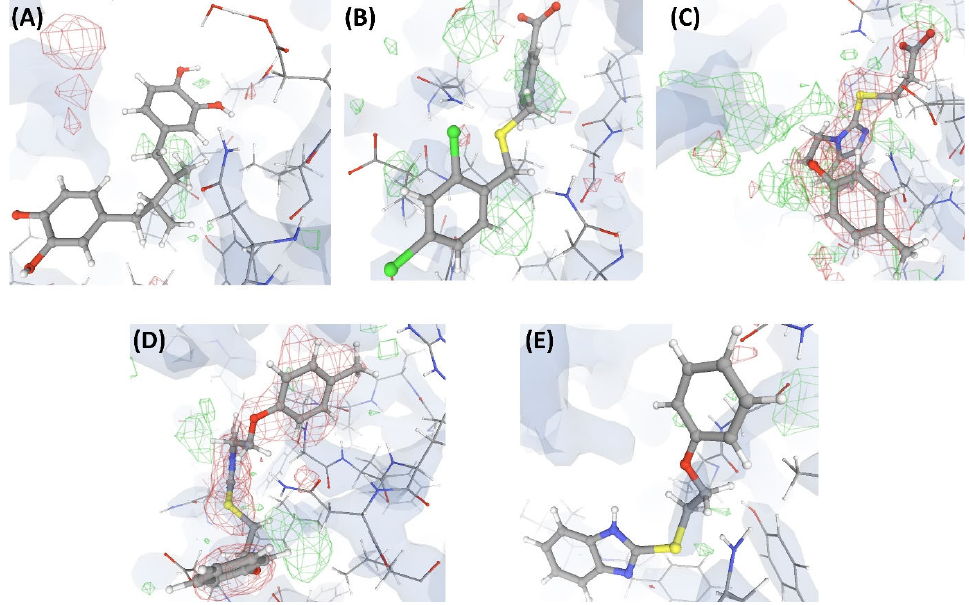
Figure 4. Electron density maps around the ligands bound at site S1 of the structures discussed in case study ‐ 1. ( A ) L1 in C1 (2.3 Å). ( B ) L2 in C2 (2.3 Å). ( C ) L3 in C3 (2.4 Å). ( D ) L4 in C4 (2.5 Å). ( E ) L10 in C17 (2.5 Å). The ligands are shown as a ball and stick model. The neighboring protein residues are shown as thin sticks. The blue translucent blobs are the ‘2 mFo ‐ DFc’ maps contoured at 1.5 σ , surrounding all well ‐ determined atoms in the models. The ‘mFo ‐ DFc’ maps (also called difference; shown as mesh) are colored as red (negative density difference contoured at ‐ 3 σ ) and green (positive density difference contoured at +3 σ ). The red density around an atom indicates either the atom is not present in the crystal or not well determined by the data or is an indicator of other aspects of incorrect modeling. The green density suggests those aspects of a structure that are reflected in the experimental data but have not been accounted for in the model. The same representation styles and contour levels are used in all the figures presented in this article. The images were generated with the 3D visualizer freely available on the PDBe website. Readers are encouraged to refer to the blog available at the PDBe website for a detailed explanation and guide [25]. The numerical suffixes to ‘L’ indicate the corresponding complex (C1/C2/C3/C4) to which the respective ligand is bound at site S1. The ligand L’ at S2 is categorized as ‘Dubious’ by VHELIBS in all four complexes, indicating no major quality concerns. Visual inspection confirmed that L’ is adequately supported by the electron density in all the complexes (Figure 5), but the ligands bound at S1 in all four complexes are poorly supported by the electron density (Figure 4). VHELIBS analysis categorized the ligands at S1 as ‘Bad’ in three (C1, C2, and C3) out of the four structures (Table 1). In the fourth complex (C4), the ligand (L4) could not be analyzed by VHELIBS. This is because VHELIBS identified L4 to be covalently bonded to P1, and evaluation of the quality of covalently bound ligands is beyond the scope of VHELIBS. Inspection of the bound pose of L4 in P1 revealed that a few ligand atoms are involved in steric clashes with the protein binding site residues (Figure S1). The close proximity between the protein and ligand atoms possibly prompted VHELIBS to recognize L4 as a covalently bound ligand. The